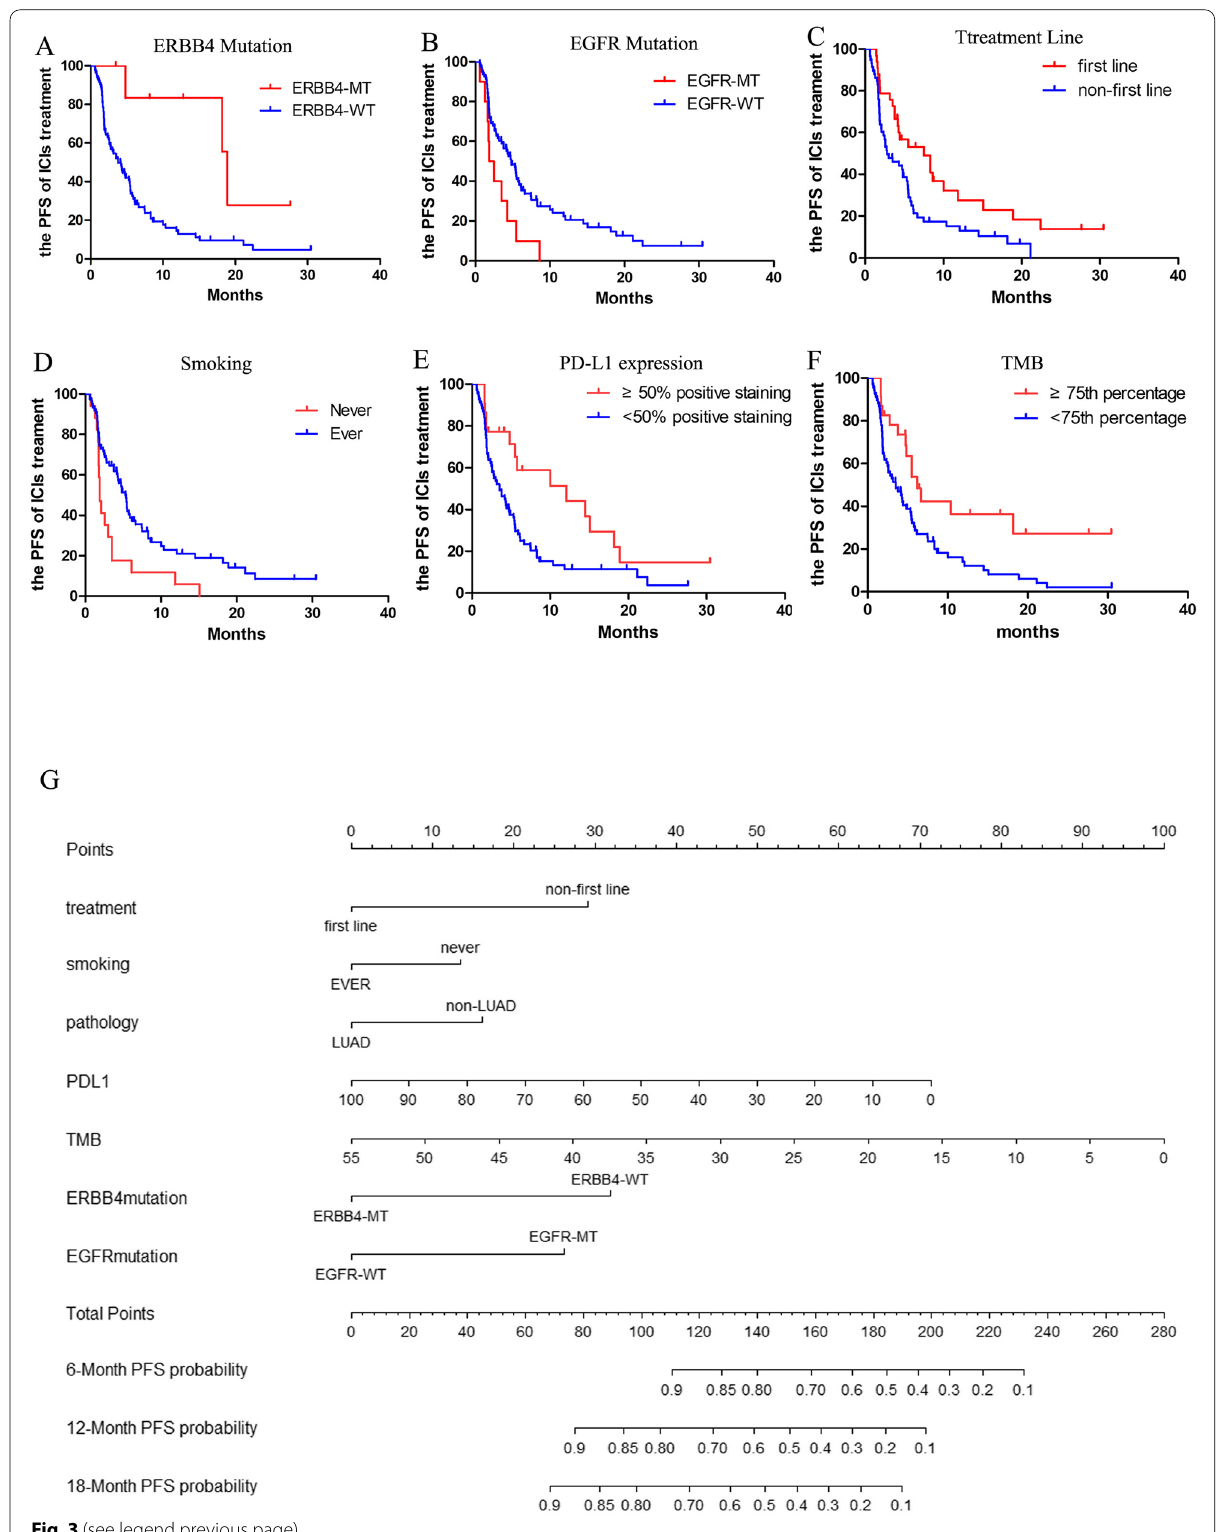
Fig. 3 (see legend previous